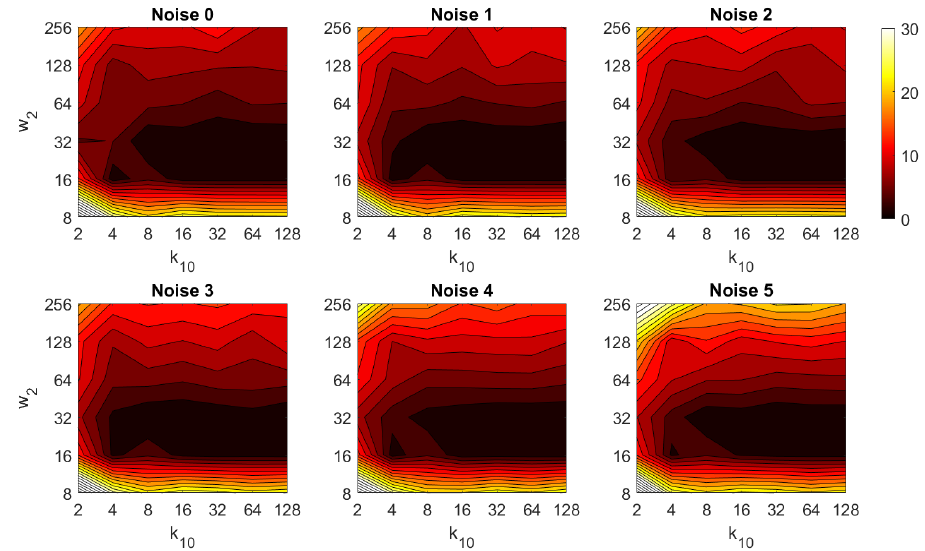
Figure 41. BG orientation estimation in the presence of noise. Average orientation error (deg).